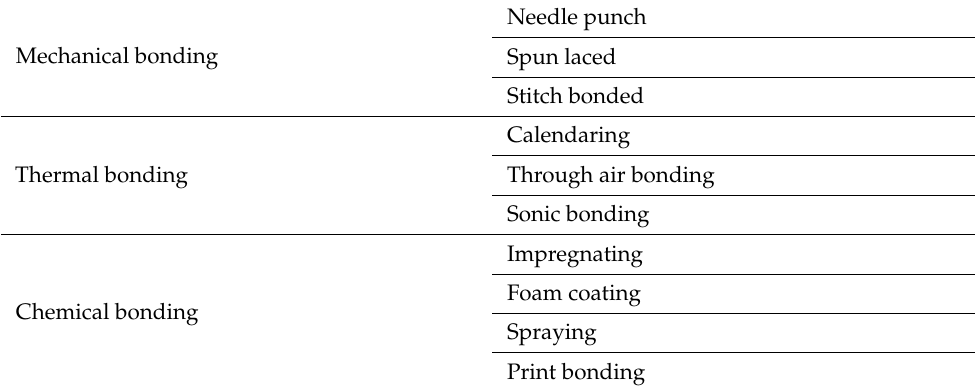
Table 1. Classification based on web bonding.